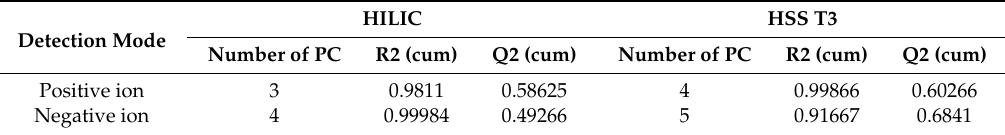
Table 2. The evaluation parameters of the PLS-DA